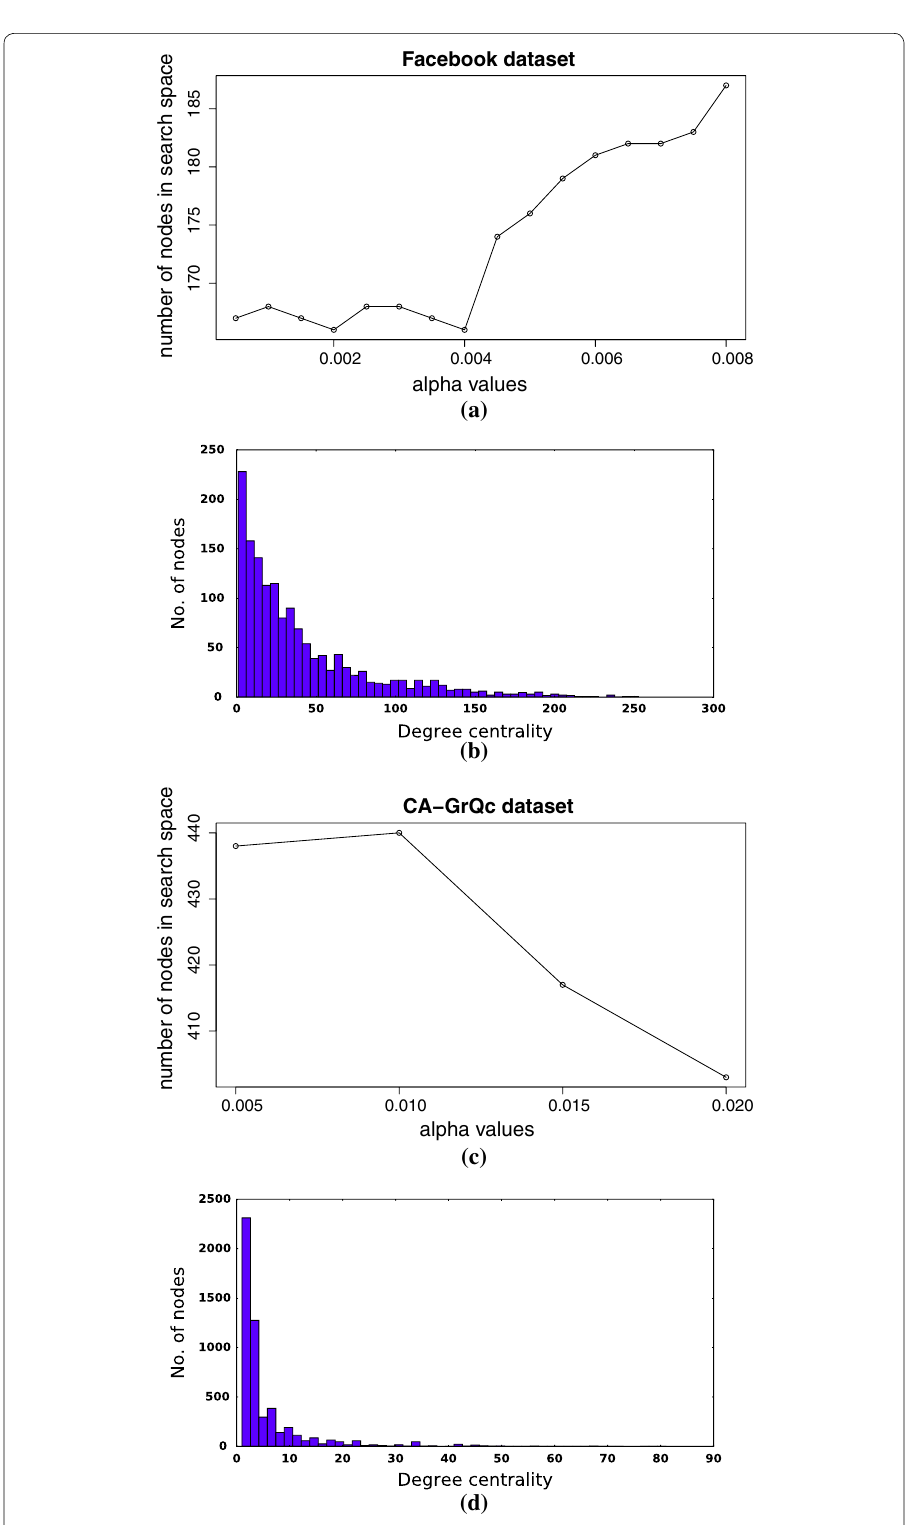
Fig. 3 Experimental results of undirected datasets. a α vs number of nodes in search space for Facebook dataset. b Degree centrality distribution of Facebook dataset. c α vs number of nodes in search space for CA- GrQc dataset. d Degree centrality distribution of CA-GrQc